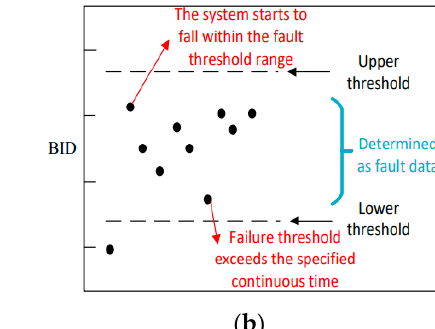
Figure 6. Schematic diagram of the discriminant rule: ( a ) abnormal data determination and ( b ) faulty data determination.